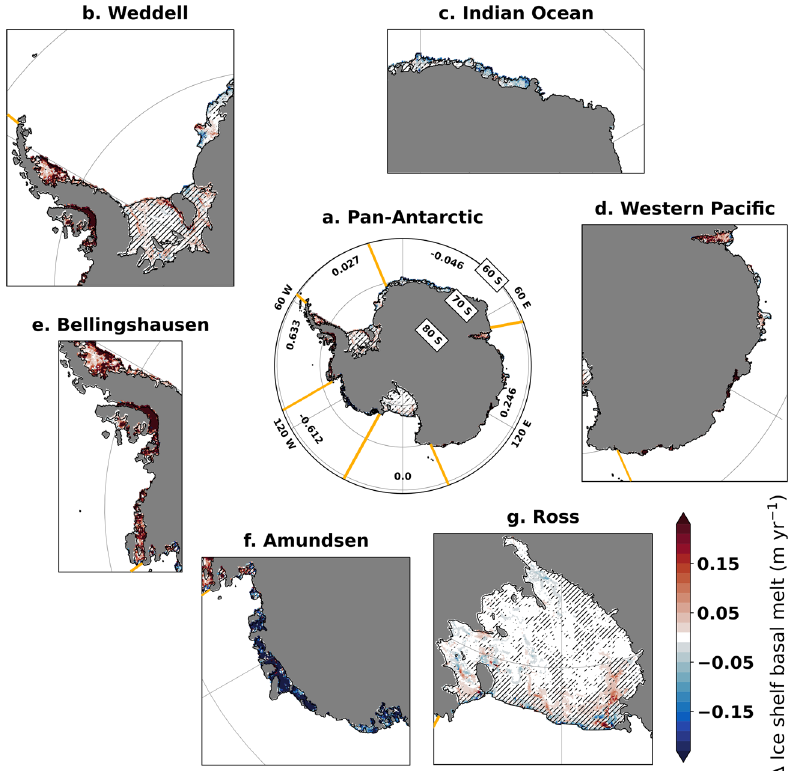
Fig. 1 Spatial variations of ice-shelf basal melt rate change due to a positive SAM perturbation. Maps of the ice-shelf basal melt rate change between the SAM + run and the CTRL run averaged over years 25 to 29 (m water equivalent yr − 1 ), ( a ) at the pan-Antarctic scale and ( b – g ) for each of the six regions delimited by the orange lines in ( a ) (see also Fig. S1). Mean values for each of the six regions are indicated in ( a ). Hatching indicates non-signi fi cant changes at the 95%